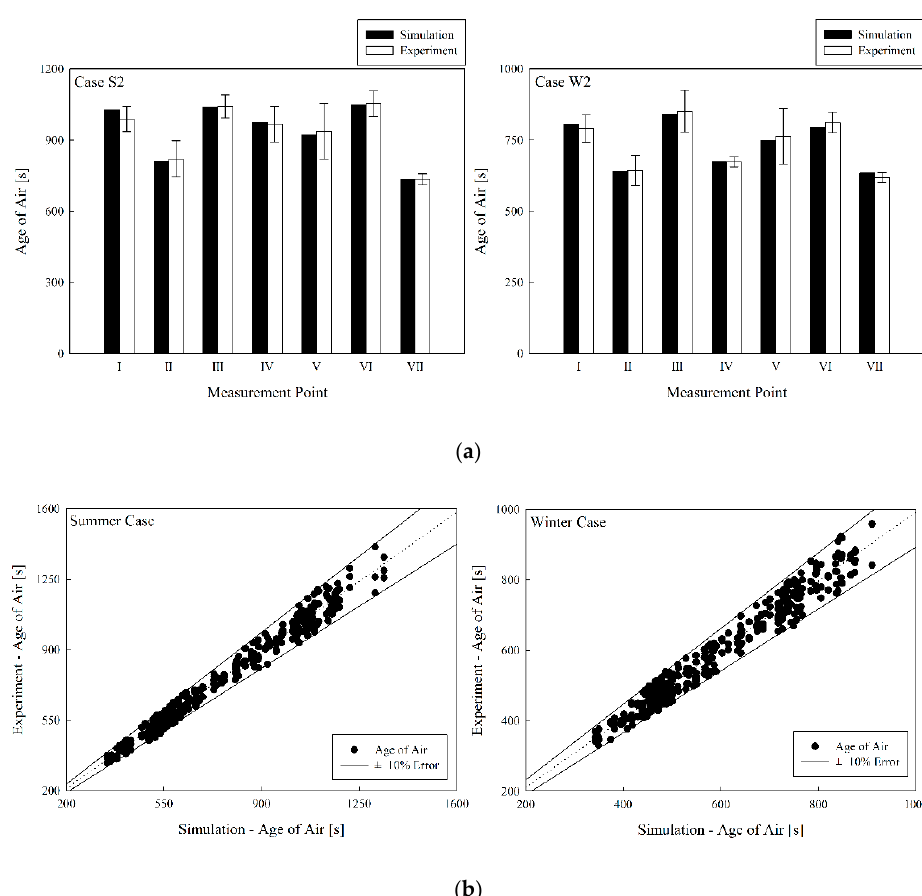
Figure 5. Comparison of age of air between experiment and simulation; ( a ) comparison of Cases S2 and W2; ( b ) comparison of all cases in summer and winter.